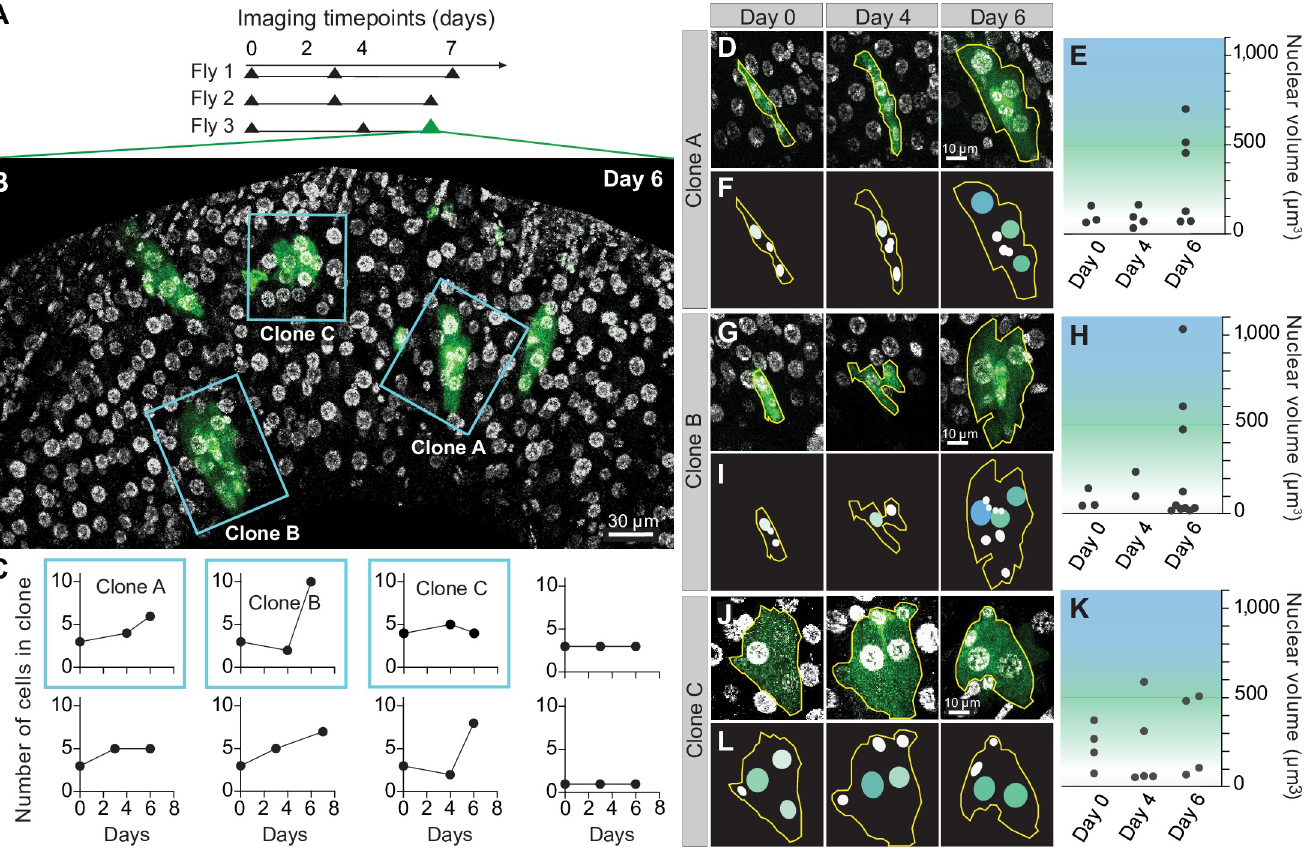
Fig 3. Serial imaging reveals longitudinal dynamics of midgut stem cell lineages. (A) Time points for serial imaging of GFP-marked midgut stem cell clones. Clones arose spontaneously during adult days 0–4. The first imaging time point, which was performed at adult day 4, is designated as day 0 in the experiment schematic. (B) Clones form organ-level patterns that enable their reidentification across imaging sessions. Blue boxes outline 3 midgut clones in Fly 3 that were tracked for the duration of the experiment. Green, GFP-labeled clones; grayscale, nuclei. See S4 Fig. (C) Longitudinal dynamics of clone cell addition and loss. Cells were counted at each imaging time point for 8 clones from the 3 animals in A. Between time points, numbers of cells per clone either increased, decreased, or remained constant. The data underlying this figure are included in S1 Data. (D,G,J) Time-series images of individual clones. Clones A, B, and C from Fly 3 are shown. See S4 Fig and S7 Movie. (E,H,K) Some clone cells differentiate into enterocytes during the imaging time course. Enterocyte differentiation was characterized by increased nuclear volume (green-to-blue shading; see S5 Fig). Over time, cells in clones became more likely to exhibit nuclear volumes typical of enterocytes ( > 300 μ m 3 ). The data underlying this figure are included in S1 Data. (F,I,L) Cartoons of clones. Nuclei in cartoons are color-coded to represent the measured nuclear volumes of individual clone cells. Volumes correspond to the white-green-blue color scale in E, H, and K. Genotype for all panels: UAS-CD8-GFP , hs-flp12; tubGal4; FRT82 , tubGal80/FRT82 . All images are projections of confocal stacks. CD8 , membrane protein CD8; FRT , Flippase Recognition Target; GFP , green fluorescent protein; hs-flp , heat-shock flippase; tub , α Tubulin84b promoter; UAS , Upstream Activation Sequence.